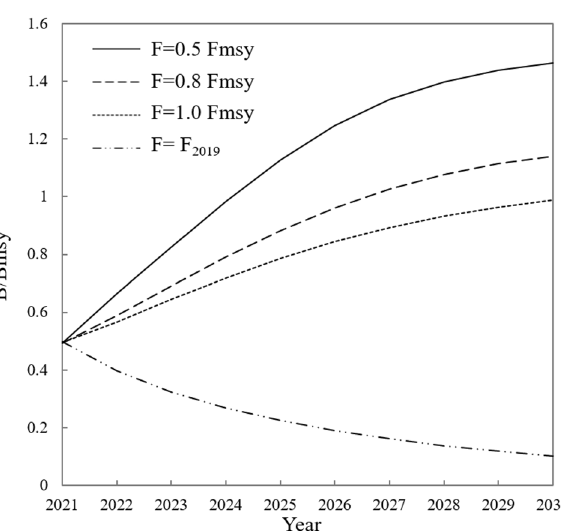
Figure 3. Rebuilding of B/B msy in 2021–2030 under different simulating scenarios. The goal of resource management is that the remaining amounts of fisheries should be larger than the volume of biomass capable of producing MSY ( B > B msy or B / B msy >